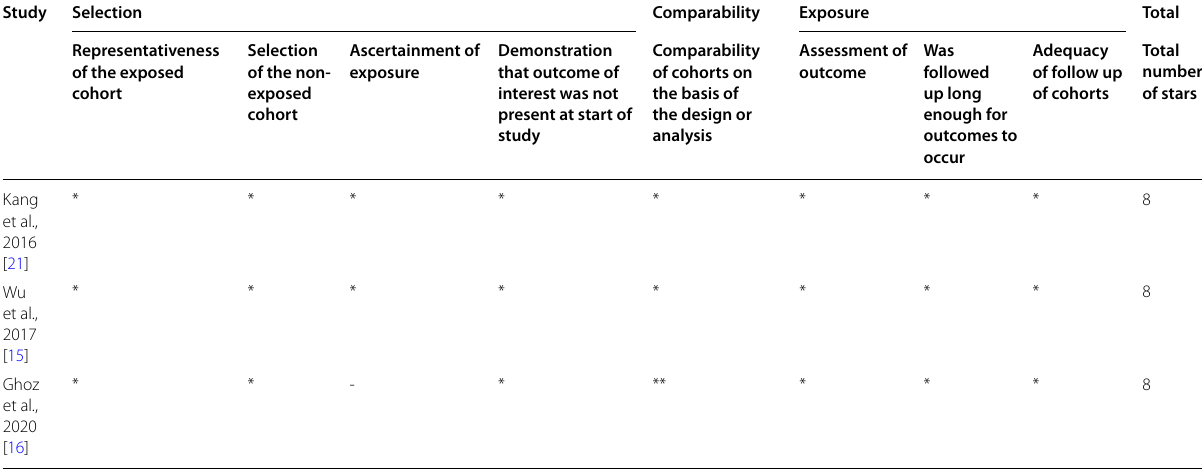
Table 3 Newcastle-Ottawa Scale (NOS) for assessing the quality of observational studies Study